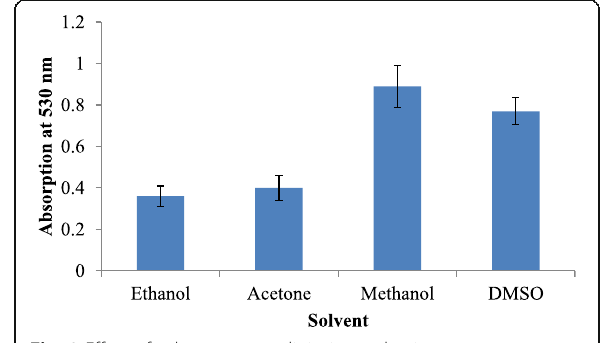
Fig. 8 Effect of solvents on prodigiosin production